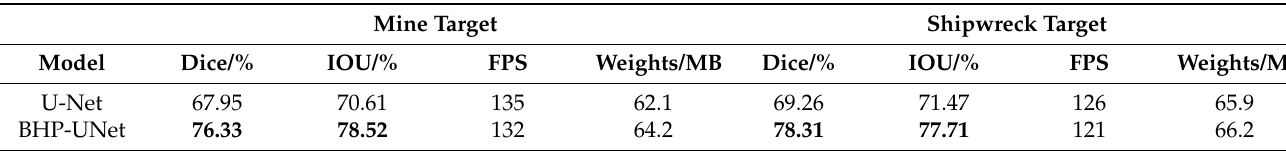
Table 7. Influence of the BHP module on